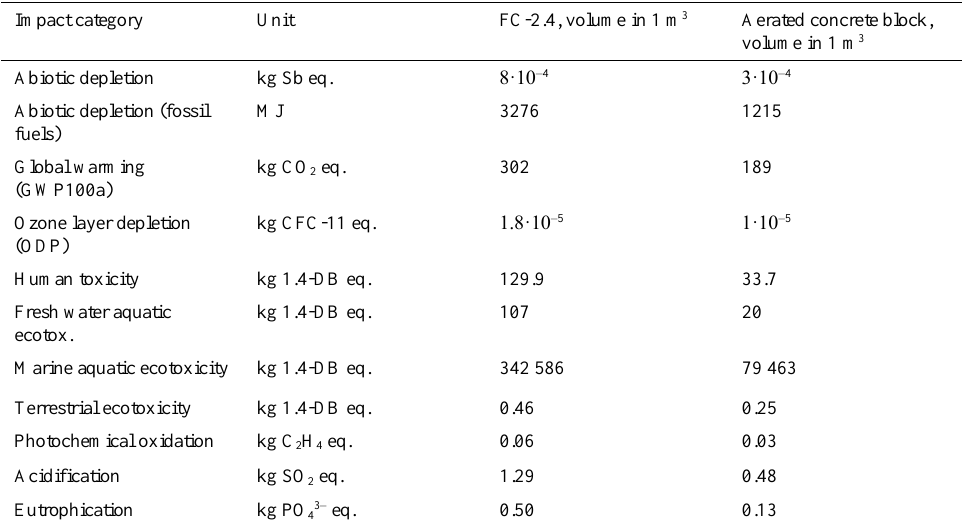
Fig. 6. Foam concrete FC-2.4 impact assessment compared with aerated concrete block by CML-IA baseline V3.04/EU25. T ABLE 8. C OMPARING FC-2.4 AND A ERATED C ONCRETE B LOCK BY CML-IA B ASELINE